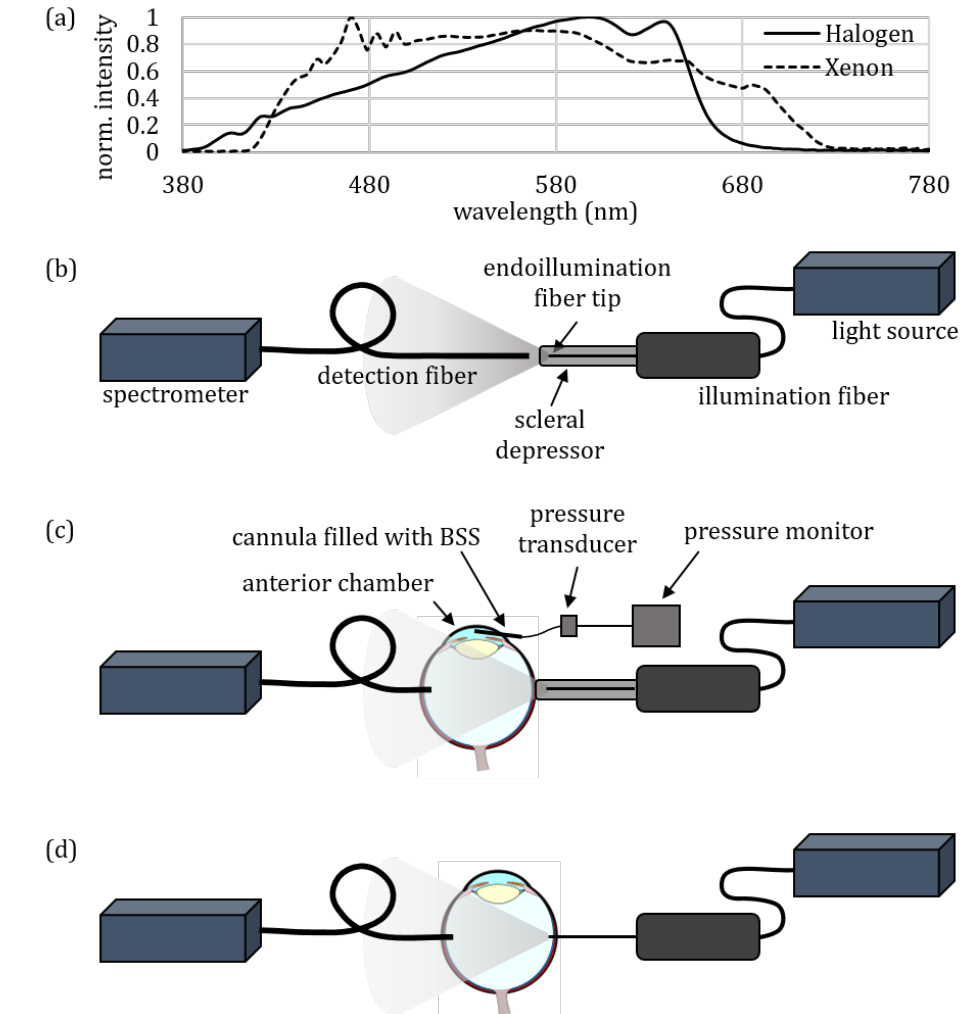
Figure 2. ( a ) Normalized intensity distribution of the halogen light source (solid line) and xenon light source (dashed line). ( b ) Set-up for determining the CCT of the lighting systems. ( c ) Set-up for